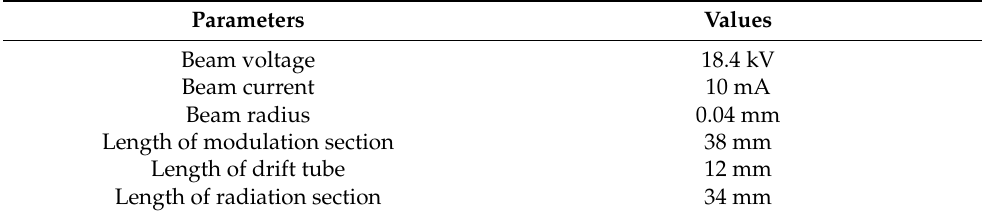
Table 2. Parameters of the HHTWT.